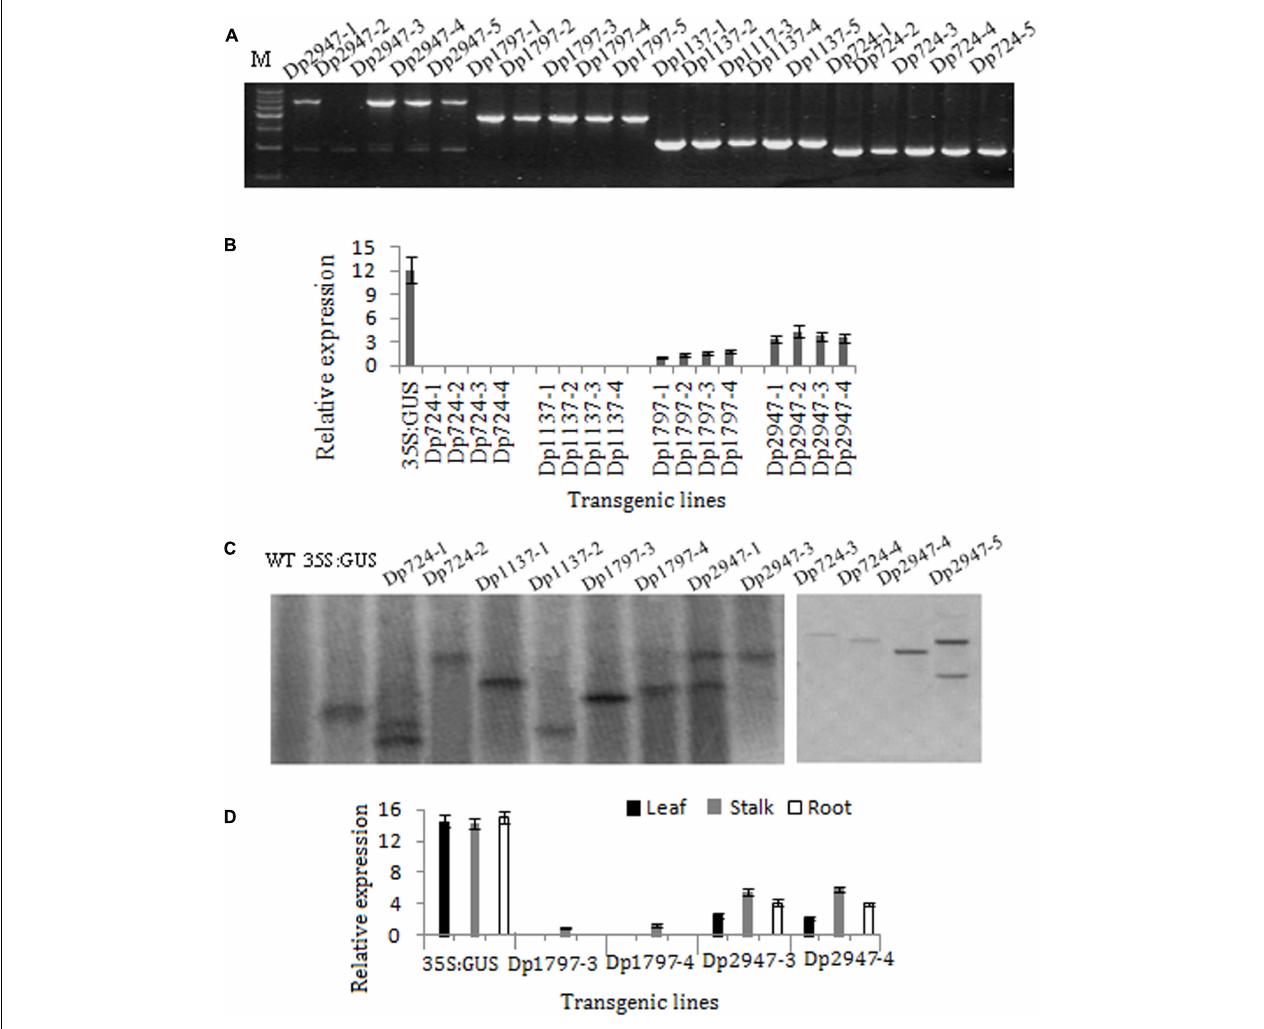
FIGURE 3 | Identification of transformed Arabidopsis plants. (A) DNA-PCR analysis of transgenic plants. (B,D) Expression levels of GUS under the control of TaSnRK2.8 promoter deletion segments. Values are means ± SD ( n = 3). (C) Southern blot analysis of transgenic plants. Total genomic DNA from the transgenic Arabidopsis leaves was digested with Eco RI. A DIG-labeled DNA fragment of GUS was used as the hybridization probe.